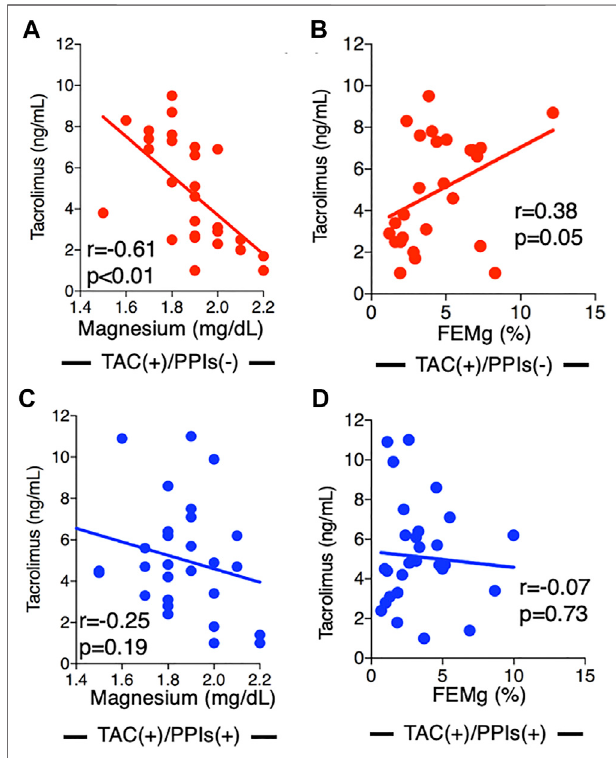
FIGURE 2 | Associations between tacrolimus concentration and magnesium level and tacrolimus concentration and fractional excretion of magnesium by drug. In patients not using PPIs, TAC concentration was signi fi cantly correlated with Mg level (r (cid:1) − 0.61, p < 0.01) (A) and FEMg (r (cid:1) 0.38, p (cid:1) 0.05) (B) . In patients treated with both TAC and PPIs, no association wasobservedbetween TAC concentrationand Mglevel (r (cid:1) 0.25, p (cid:1) 0.19) (C) or FEMg (r (cid:1) -0.07, p (cid:1) 0.73) (D) . PPI, proton pump inhibitor; TAC, tacrolimus; Mg, magnesium; FEMg, fractional excretion of